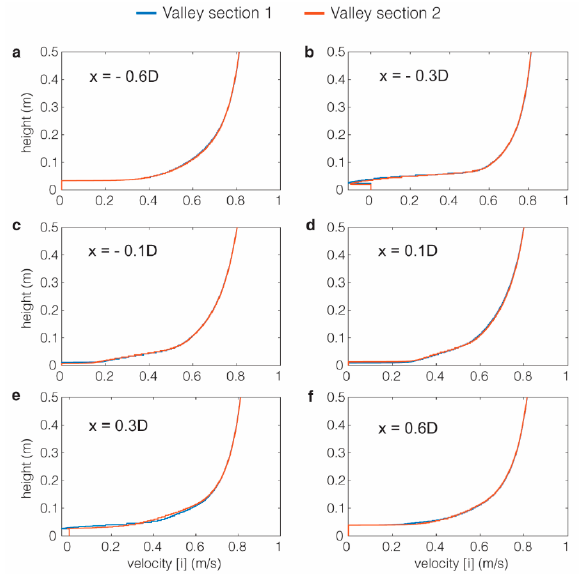
Figure 13. Vertical profiles of mean streamwise velocity in the two valley sections. ( a–f ) Changes in the vertical velocity profiles across the nest are similar for both valley sections. ( b,e ) Presence of recirculation zone in the valley depression with the weaker zone present in the downstream de- pression ( e ). Pressure coefficient distribution for ridge section one across the nest surface is given Figure 14. A sharp drop in pressure is observed at the upstream ridge before gradual in- crease downstream. This decrease in pressure accelerates the flow over the second peak. Negative pressure is observed throughout the recirculation zones. In the centre of the nest, where the eggs are laid, no sudden change in pressure is observed. Figure 14. Pressure coefficient as a function of x. 3.3. Shear Stress Distribution Wall shear stress distribution for ridge section one across the nest and comparison of the nest and surrounding seabed shear stress is given in Figure 15a,b, respectively. Mean seabed shear stress is approximately 0.598 Pa. The highest shear stresses are measured across the outer peaks at the upstream (3.599 Pa) and downstream ridges (2.982 Pa), with the lowest shear stress (0.002 Pa) observed downstream beyond the edge of the recircula- tion zone (0.2D). Mean shear stress within the central zone of the nest is approximately 0.291 Pa. This is a remarkable observation as the regions of higher shear stress at the outer peaks is where the pufferfish ensures coarser material is present during construction of the nest (see Figure 16), and the central zone is composed of fine sand particles.